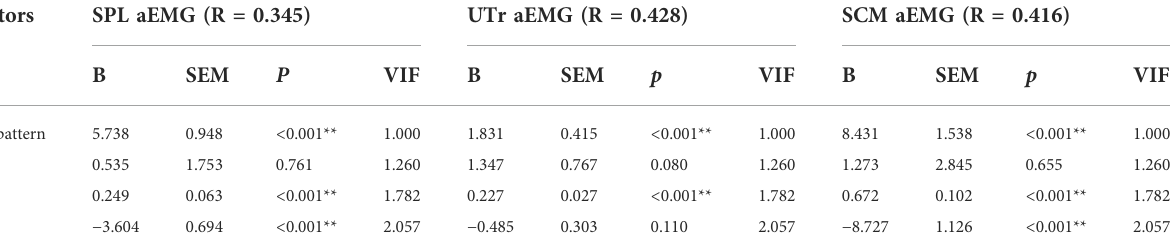
TABLE 4 Multiple linear regression analysis for aEMG of the cervical rotators.